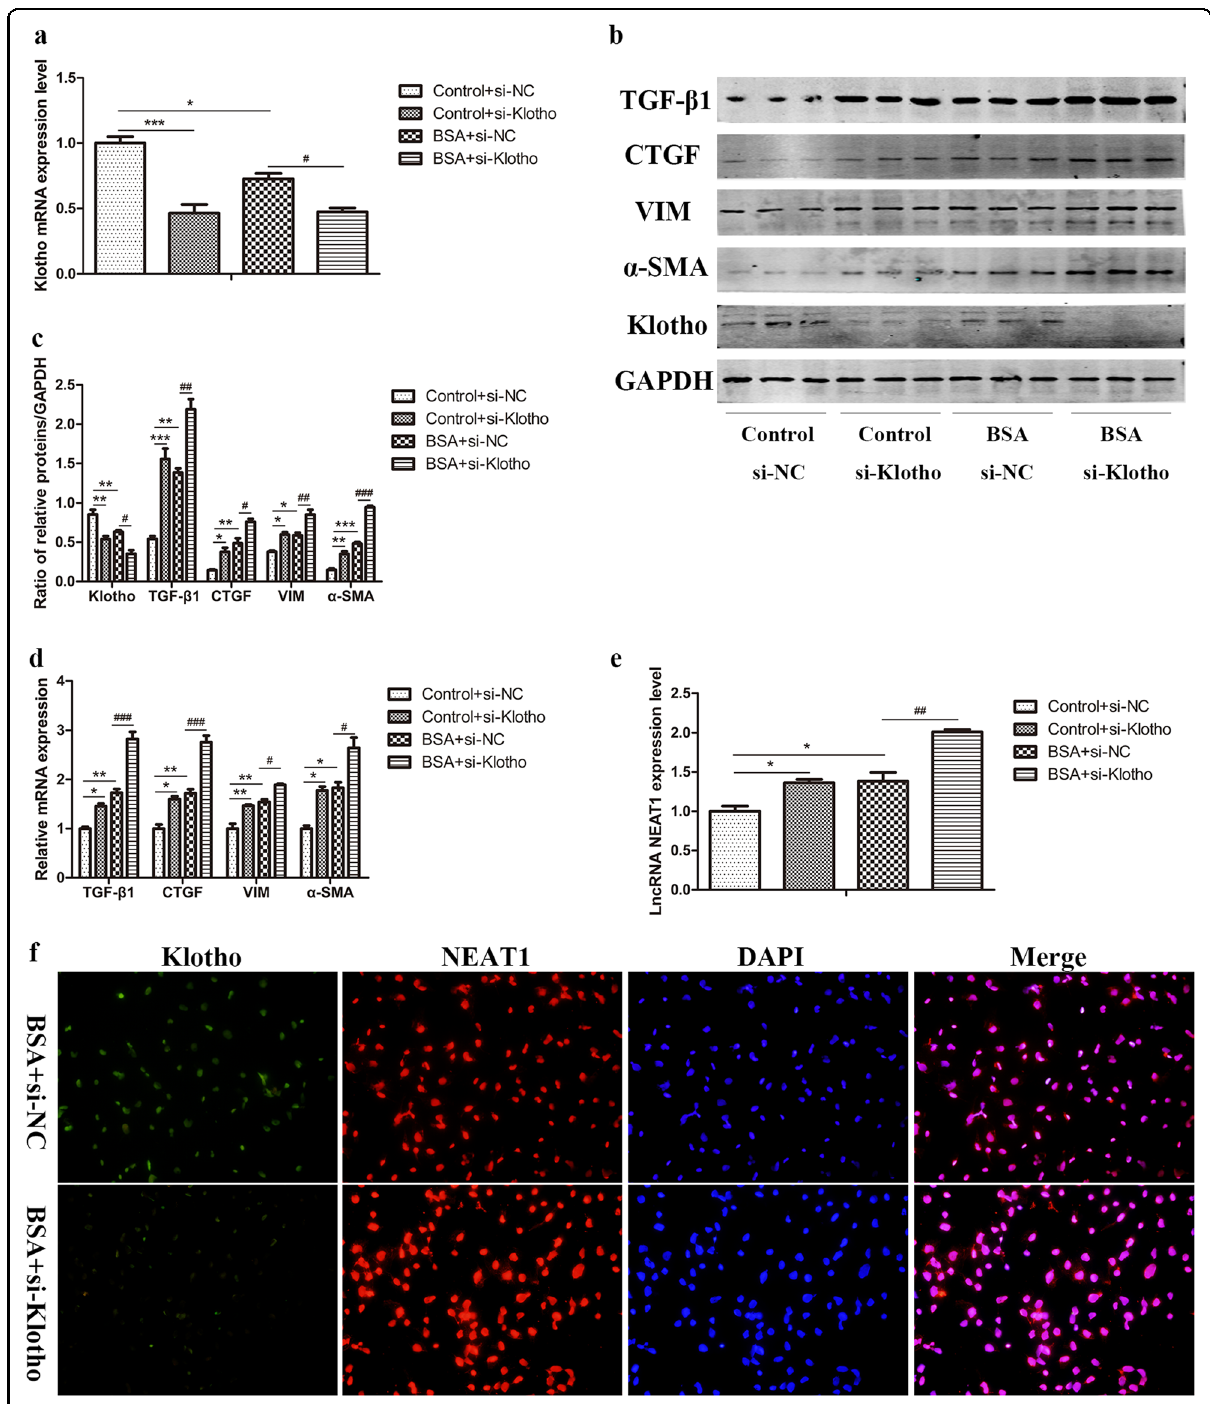
Fig. 7 Knockdown of Klotho further promoted NEAT1 expression in BSA-induced HK-2 cells. HK-2 cells were transfected with si-Klotho and treated with 10 mg/ml BSA for 48 h. a Expression of Klotho mRNA was measured by qRT-PCR. b , c The protein levels of TGF- β 1, CTGF, vimentin, α - SMA, and Klotho were measured by western blots. d , e The mRNA levels of TGF- β 1, CTGF, vimentin, α -SMA, and lncRNA NEAT1 were measured by qRT-PCR. f Immuno fl uorescence and FISH were performed to investigate the expression and location of Klotho and NEAT1 after transfection with si- Klotho in BSA-treated HK-2 cells. * p < 0.05 vs control + si-NC, ** p < 0.01 vs control + si-NC, *** p < 0.001 vs control + si-NC; # p < 0.05 vs BSA + si-NC, ## p < 0.01 vs BSA + si-NC, ### p < 0.001 vs BSA +